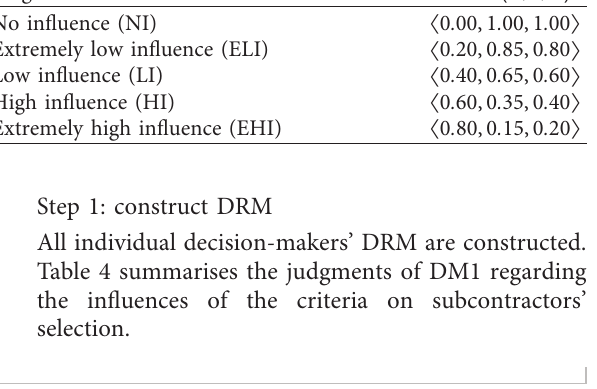
Table 3: Five-point linguistic scale [39]. Linguistic